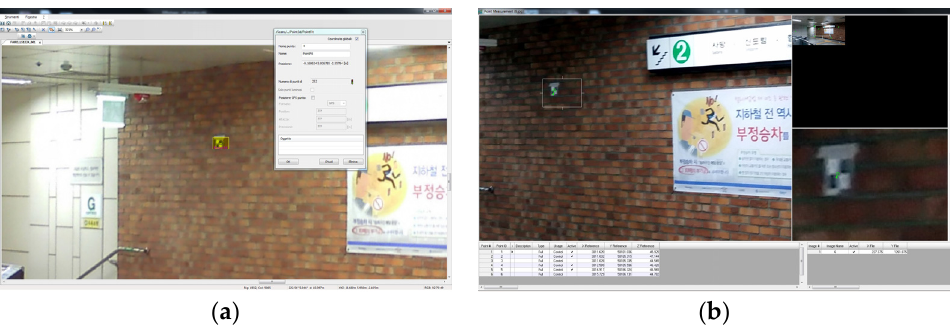
Figure 12. ( a ) GCP coordinate extraction from LiDAR data; and ( b ) GCP measurement in Erdas.